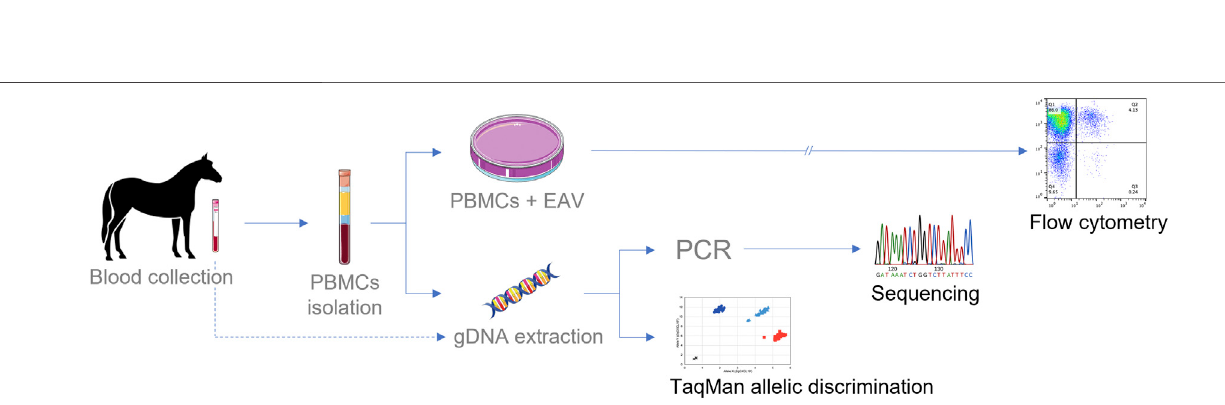
corresponding to horses with the CXCL16 S/S ( n = 30), CXCL16 S/r ( n = 74), and CXCL16 r/r ( n = 56) genotypes. The agreement